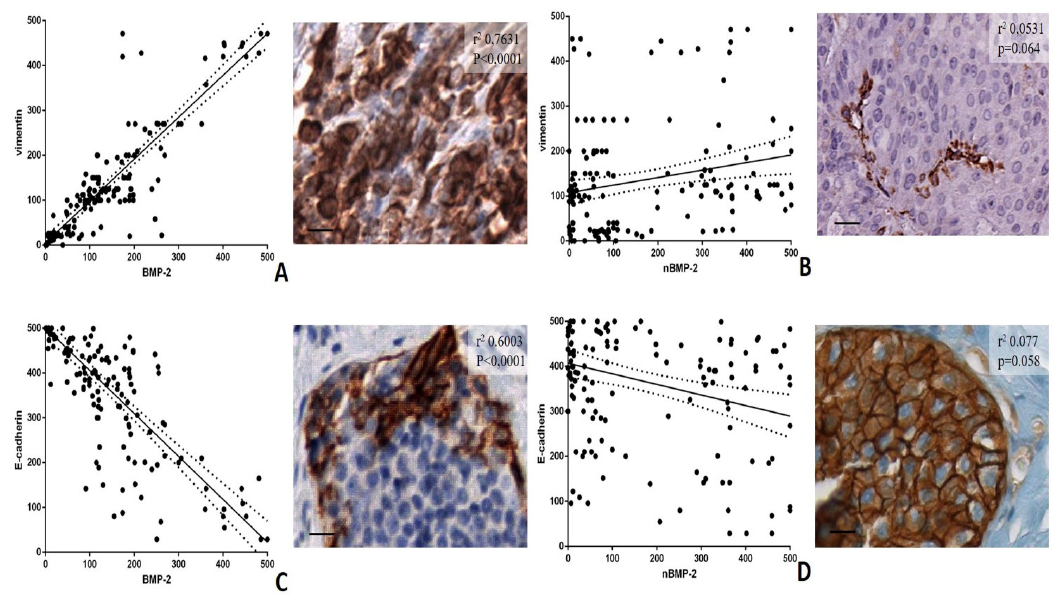
Figure 2. Linear regression analysis of the association among cytoplasmic BMP-2, nBMP-2, and EMT markers vimentin and e-cadherin. ( A ) The graph shows a significant positive association between the number of BMP-2-positive cells and vimentin. The image displays numerous vimentin-positive breast cancer cells in a case of infiltrating carcinomas ( B ) The graph displays no association between the number of nBMP-2-positive cells and vimentin. The image shows rare vimentin-positive breast cancer cells in a case of infiltrating carcinomas. ( C ) The graph shows a significant inverse association between the number of BMP-2-positive cells and e-cadherin. The image displays numerous e-cadherin negative breast cancer cells. ( D ) The graph displays no association between the number of nBMP-2-positive cells and e-cadherin. The image shows e-cadherin-positive breast cancer cells. The scale bar represents 200 μ m for each image.